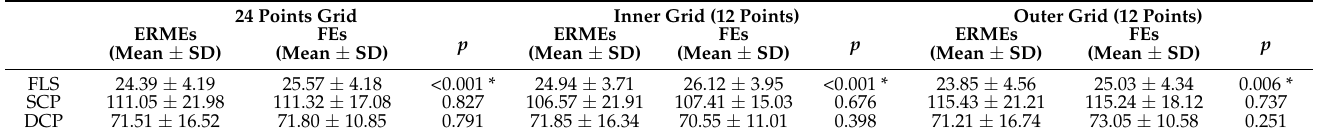
Table 1. Descriptive statistics of focal light sensitivity (FLS), flow signal in superficial capillary plexus (SCP) and deep capillary plexux (DCP) in the global, inner and outer grids. 24 Points Grid Inner Grid (12 Points) Outer Grid (12 Points) ERMEs FEs ERMEs (Mean ± SD) (Mean ± SD) (Mean ±